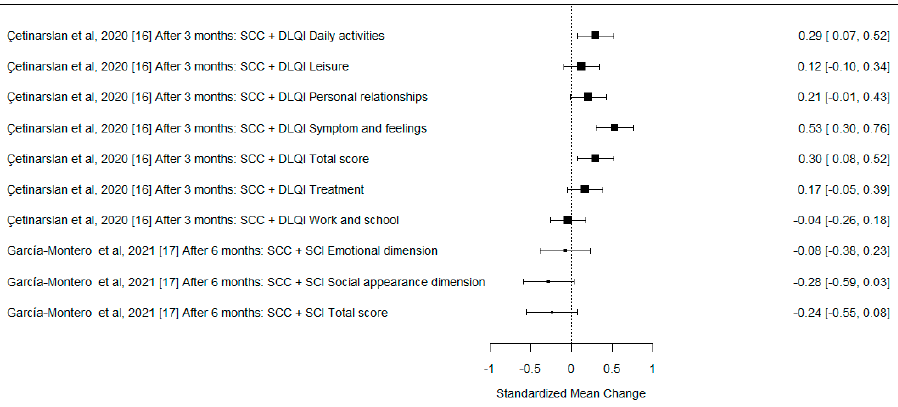
Figure 4. The forest plot for differences in the preoperative and postoperative QoL measures for the SCC group. SMD with 95% CI.